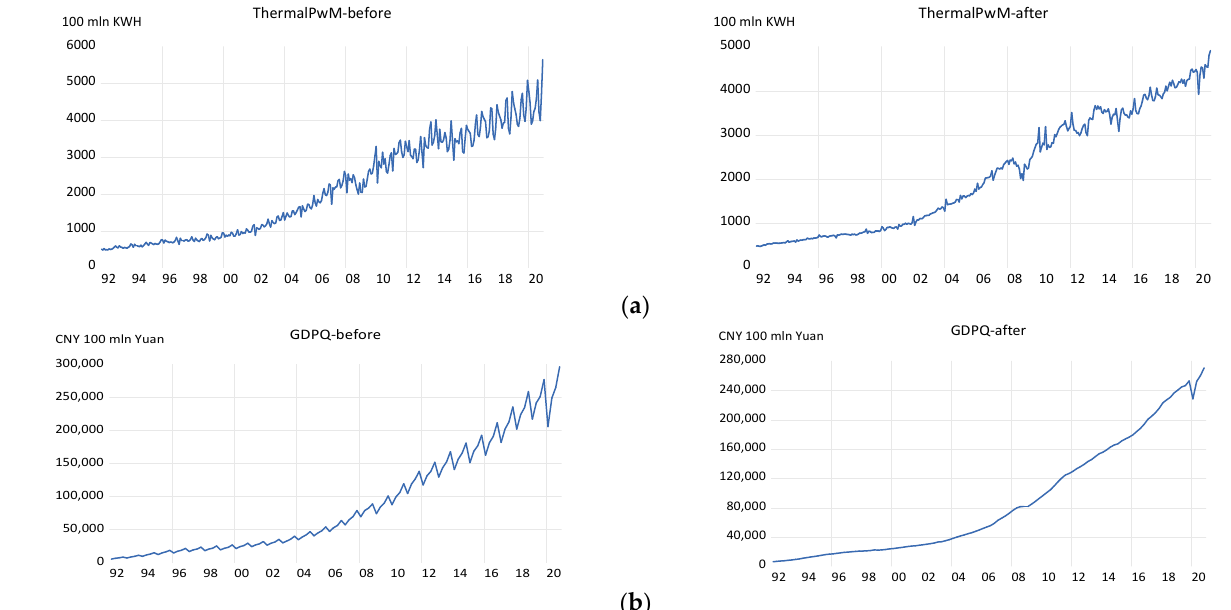
Figure 2. ( a ) Graphs showing the ThermalPwM data before and after de-seasoning. ( b ) Graphs showing GDPQ before and after de-seasoning.